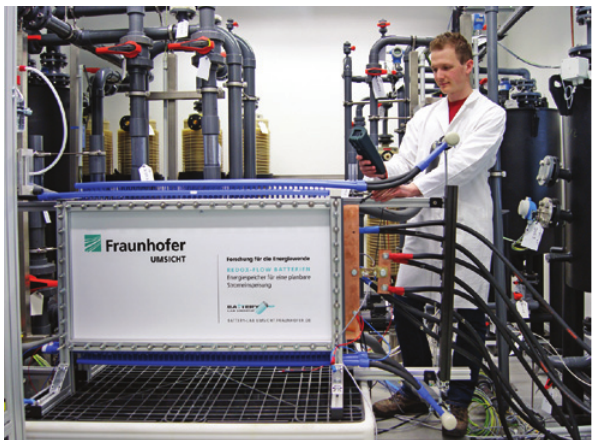
Figure 7: Scientists at Fraunhofer UMSICHT have succeeded in increasing the size and power of the battery stack by rethinking its design. © Fraunhofer